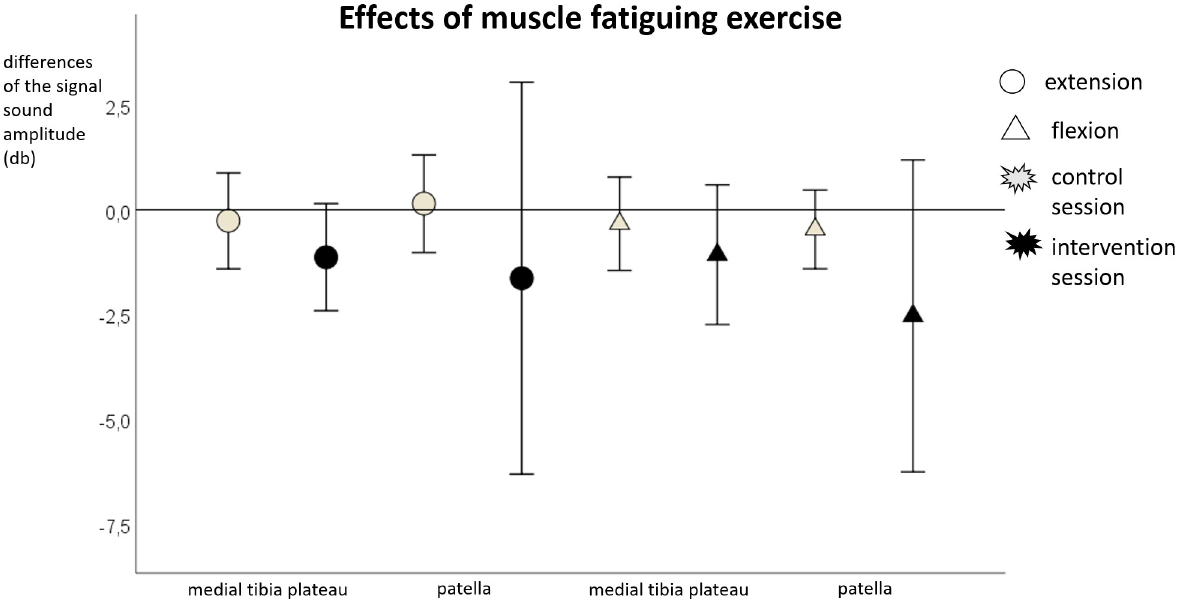
Fig 5. Mean and 95% confidence interval values of the pre-post differences of the mean sound amplitude during extension and flexion for muscle fatigue.